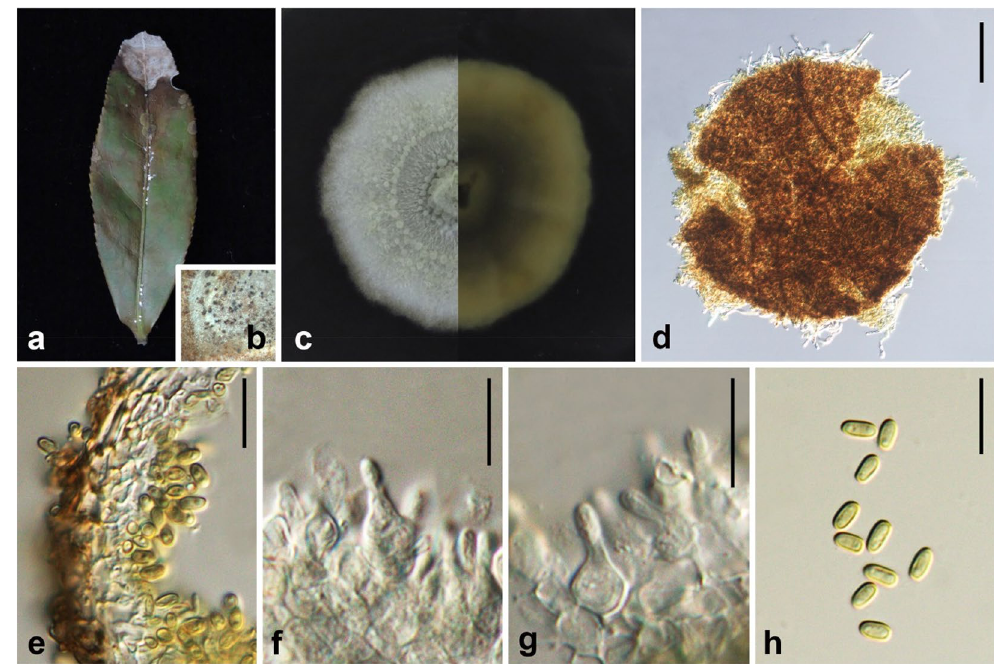
Figure 6. Leucaenicola taiwanensis (NTUH 18–094-1, holotype ). ( a ) Leaf lesions. ( b ) Appearance of conidiomata on host surface. ( c ) Cultures on PDA, from above and below. ( d ) Pycnidium. ( e ) Conidiomatal wall. ( f , g ) Conidiogenous cells and developing conidia. ( h ) Conidia. Scale bars: ( d ) = 50 μm, ( e – h ) = 10